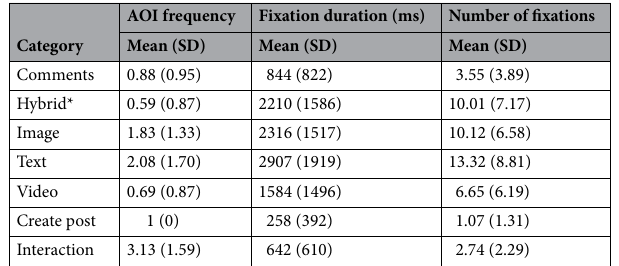
Table 4. Frequency and fixation behaviour for each area of interest (AOI) category. *An image overlaid with text, typically in a ’meme’ type format.